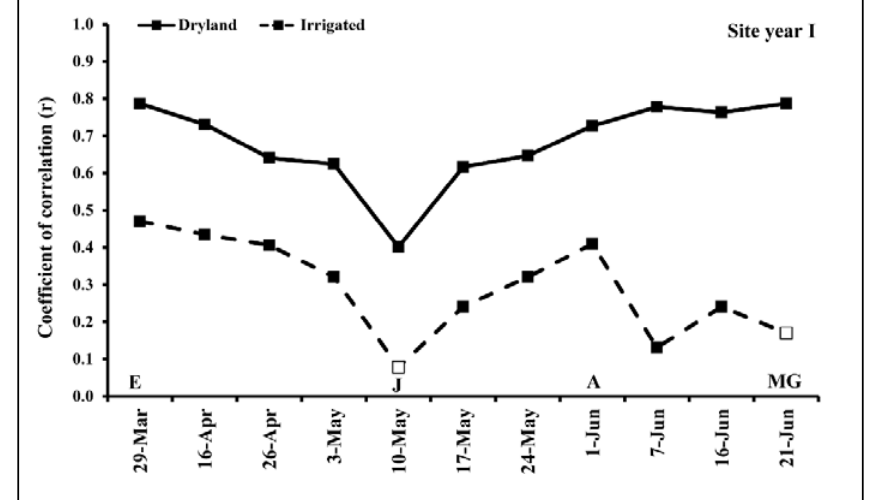
Figure 4. Correlation coefficient (r) between NDVI and grain yield across 24 winter wheat genotypes for site year I under dryland (solid line) and irrigated (dashed line) conditions across crop growth stages. Critical growth stages are indicated as A = anthesis growth stage, E = early spring growth stage, J = jointing growth stage, and MG = mid-grain filling growth stage. Solid symbols show a significant correlation between NDVI and yield ( p -value < 0.05).